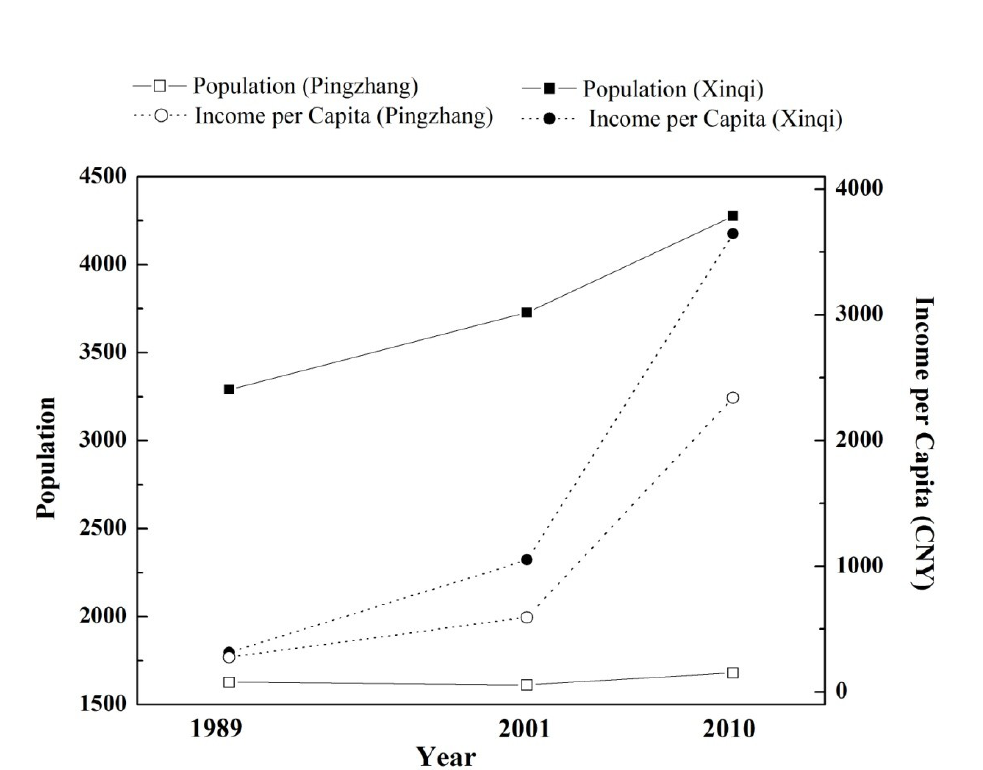
Figure 3. Income and demographic changes in Pingzhang and